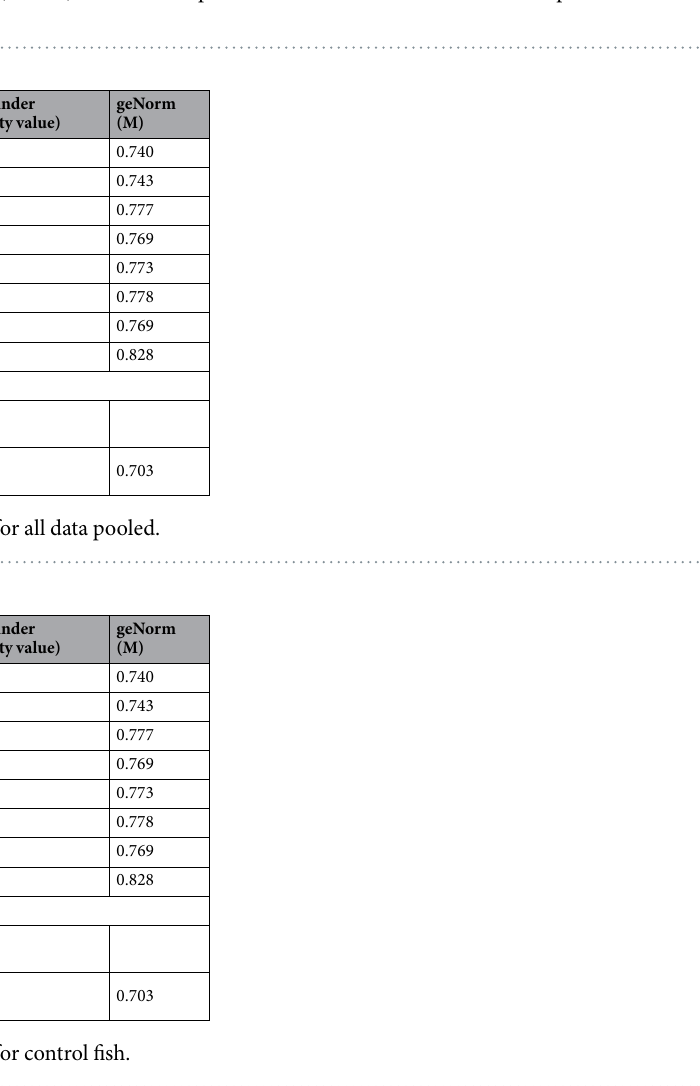
Figure 3. Plasma cortisol levels ( ± SEM) after stress experiment. * Statistical difference with respect to control (p < 0.05).